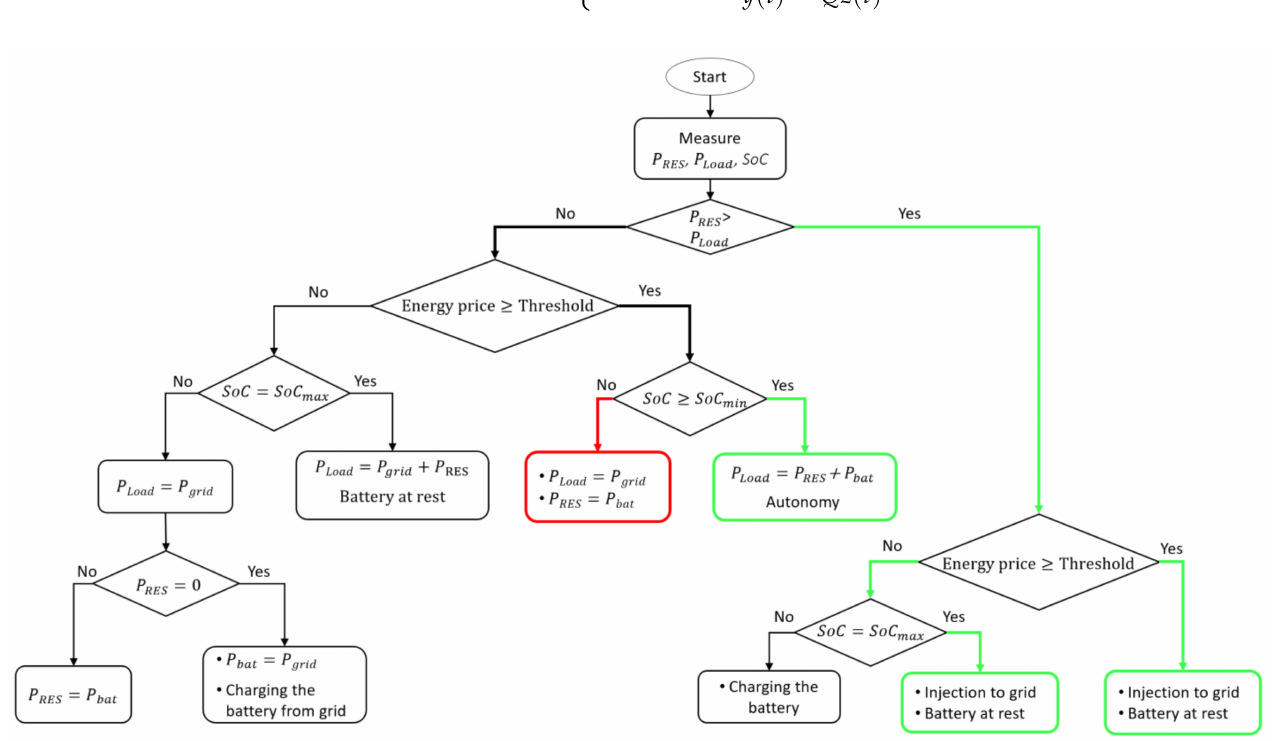
Figure 5. Energy management and control